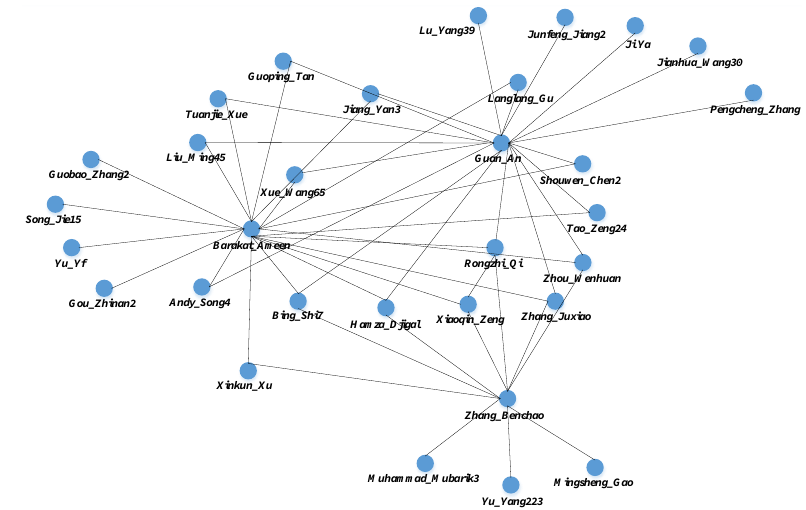
Figure 3. Following graph among